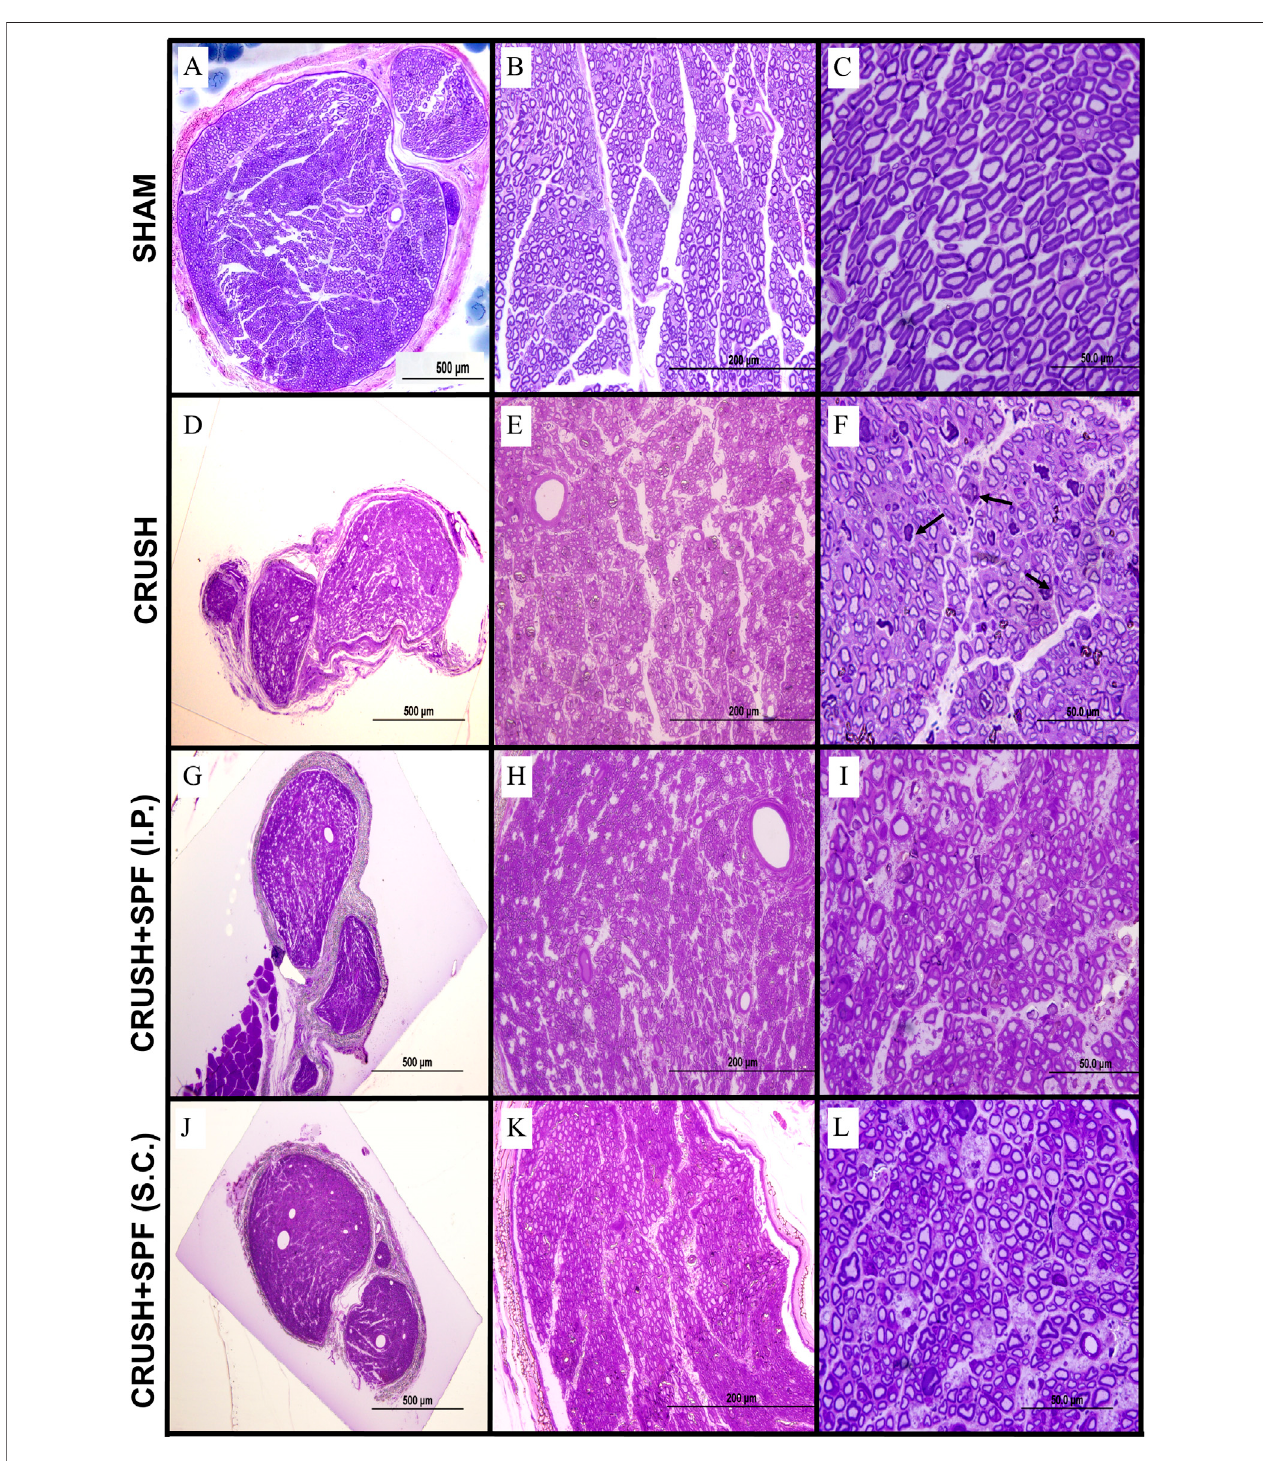
FIGURE 3 | Toluidine blue-stained photomicrographs of semi-thin transverse sections of sciatic nerves obtained from animals in the SHAM ( A – C ), CRUSH ( D – F ), CRUSH+0.5XSPF-FB(IP)( G – I )andCRUSH+1XSPF-FB(S.C.)( J – L )groupsatweek6followingnerveinjury(ColumnI; × 100,ColumnII, × 400andColumnIII, × 1,000). Although sciatic nerves from CRUSH ( D – F ) animals display regenerative recovery but still show the presence of smaller mini-fascicles nerve fi bers with thin myelin sheaths and more myelin con fi gurations and debris (arrows) at week 6 following crush injury, in contrast, sciatic nerve sections of and CRUSH + 0.5X SPF-FB(IP) ( G – I ) and CRUSH + 1X SPF-FB (S.C.) ( J – L ) groups show remarkable nerve regeneration with less myelin debris compared to those from the CRUSH ( D – F ) group. Note that the SPF-FB-treated nerves show more compactly arranged, regularly shaped, and more myelin surrounding the axons compared to the CRUSH group.